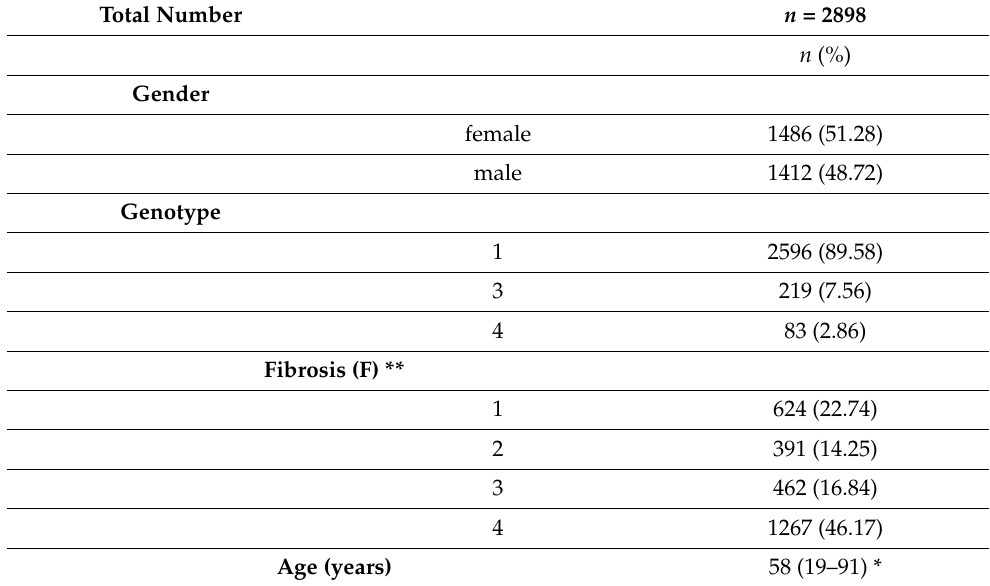
Table 1. The characteristics of the study group.